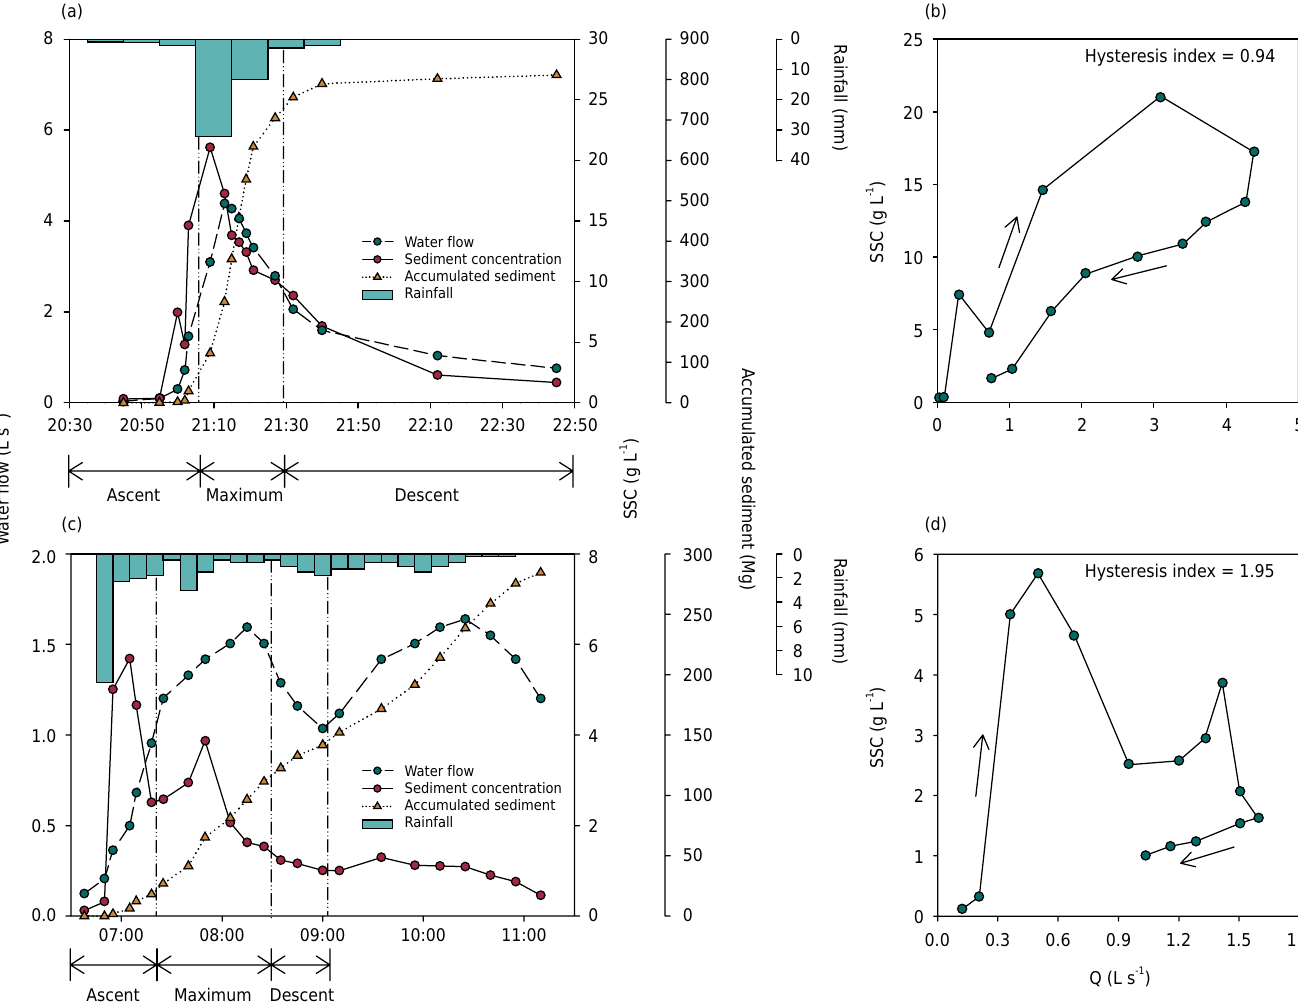
Figure 2. Rainfall, water flow, and suspended sediment concentration (SSC) at the monitoring station in the catchment outlet during the storm events occurred during the fallow (a) and tobacco transplantation (c), and hysteresis loops during the storm events occurred during the fallow (b) and tobacco transplantation (d) periods in Agudo catchment, Rio Grande do Sul,